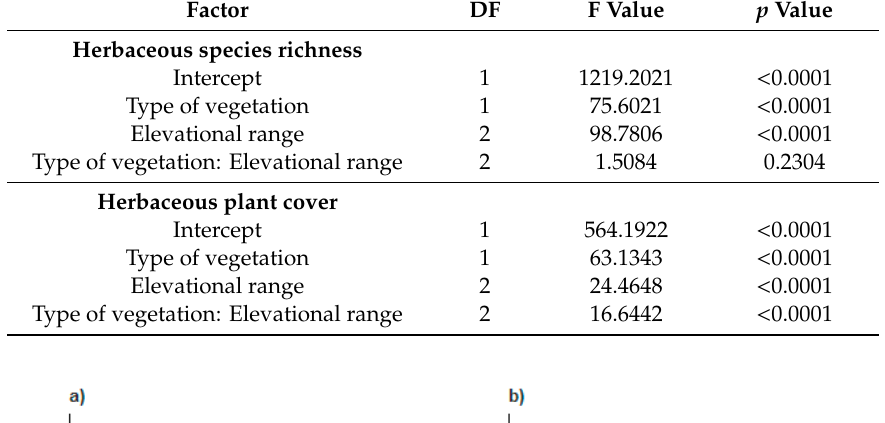
Table 2. Influence of elevational range and type of vegetation on species richness and percentage of plant cover of herbaceous vegetation according to the ANOVA analysis obtained from the linear mixed model (LMM).